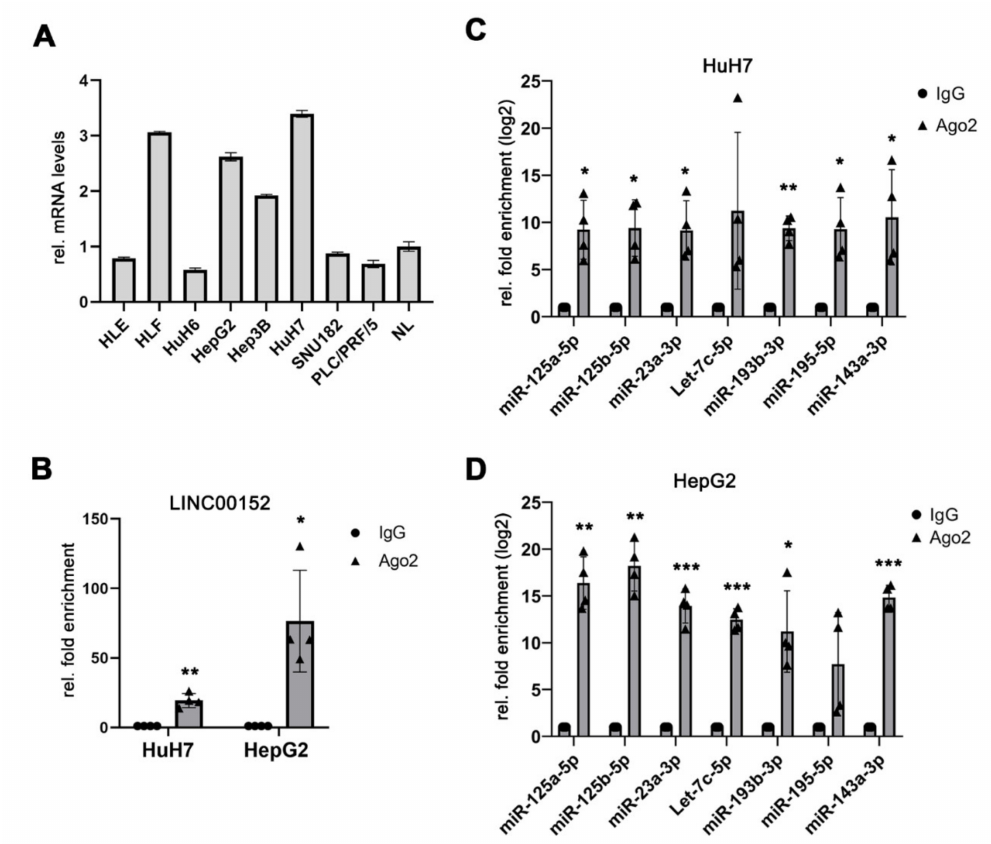
Figure 2. LINC00152 and putative miRNAs were enriched in RNP complexes in a potential LINC00152 - driven ceRNA network in human HCC. ( A ) LINC00152 expression in human HCC cell lines. ( B ) LINC00152 mRNA is enriched in AGO2 complexes of HCC cell lines compared to IgG con- trol. ( C , D ) The predicted miRNAs components of the LINC00152 ceRNA network are significantly more prevalent in AGO2-immunoprecipitated protein complexes of HuH7 and HepG2 cells compared to control. Data are presented as mean ± SD of 3 technical replicates in panel ( A ) or 4 independent experiments in ( B – D ). Welch’s t -test: * p < 0.05, ** p < 0.01, *** p < 0.001. Abbreviations: NL,